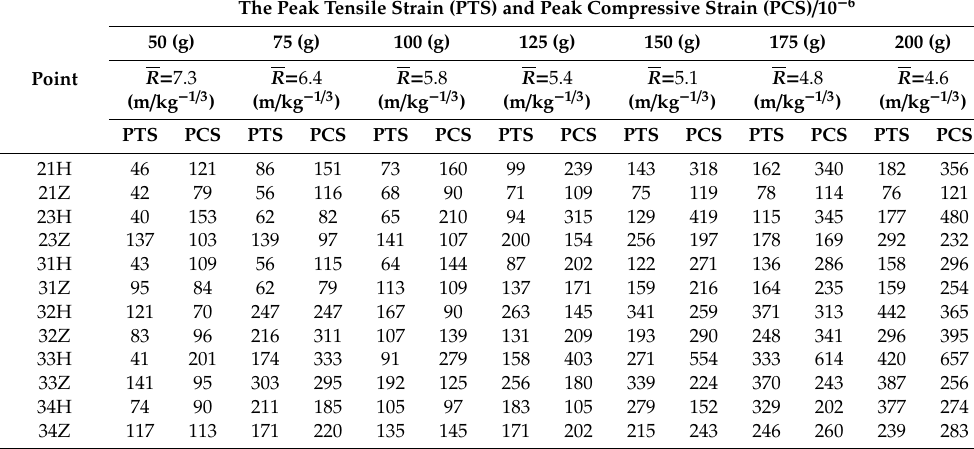
Table 3. The peak tensile strain and peak compressive strain ( R = 2.7